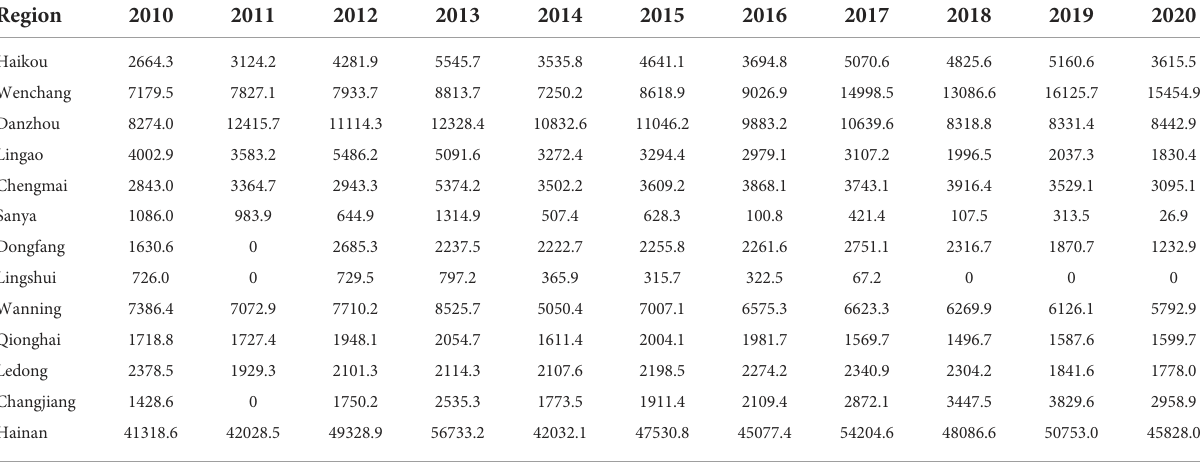
TABLE 5 N 2 O emissions of shrimp aquaculture in Hainan. Unit: MgCO 2 e yr -1 . Region